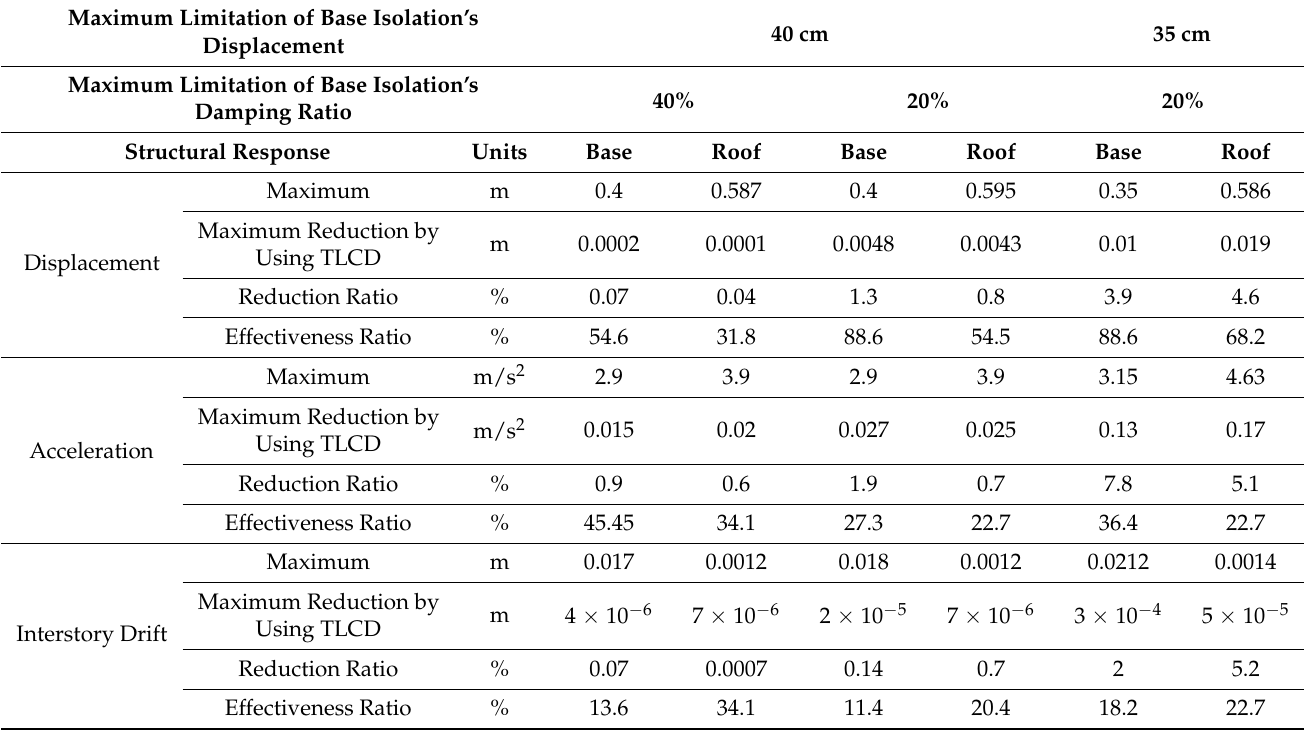
Table 7. The maximum structural responses of the base and roof levels under 44 earthquakes: effects for the hybrid controlled